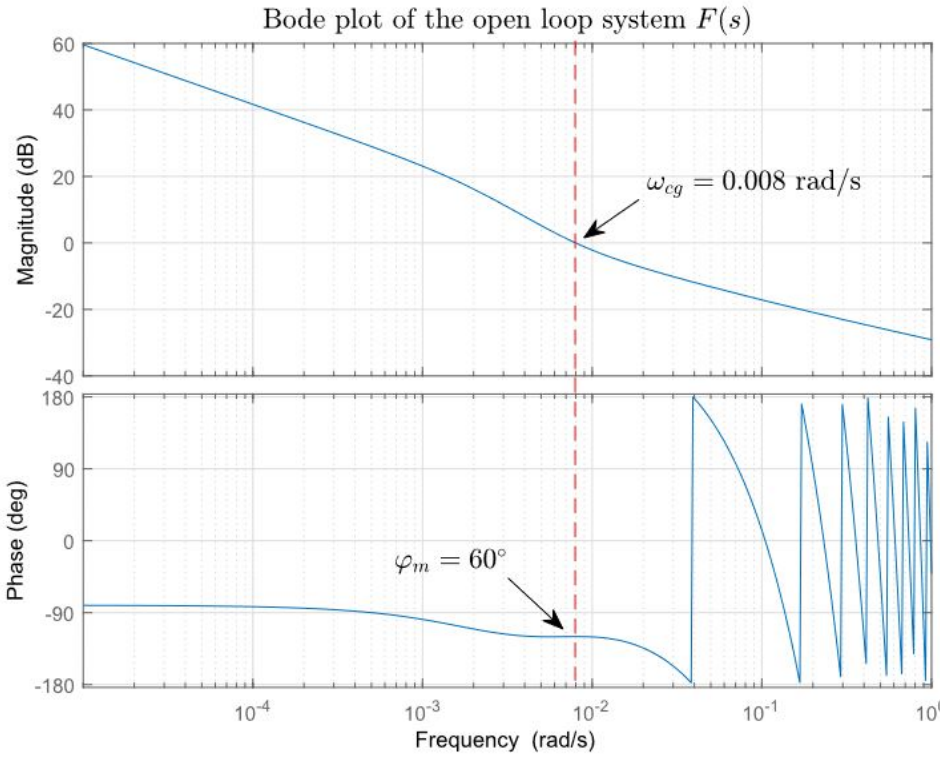
Figure 2. Bode plot comparison of frequency, phase, and magnitude in isodamping [50].